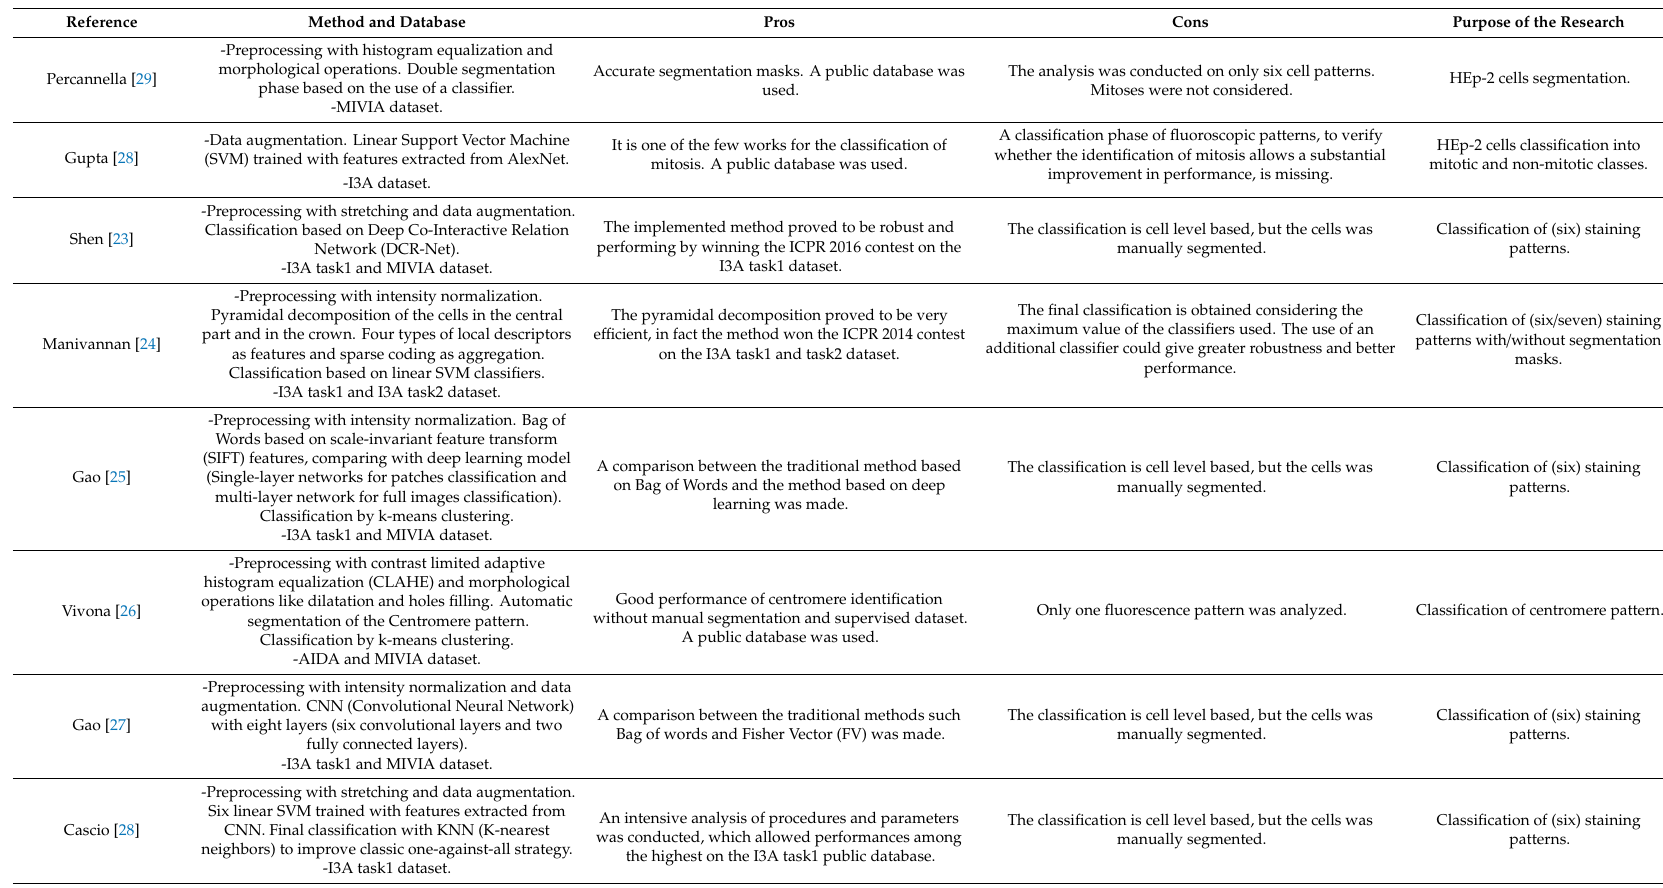
Table 1. Literature related to automatic analysis of HEp-2